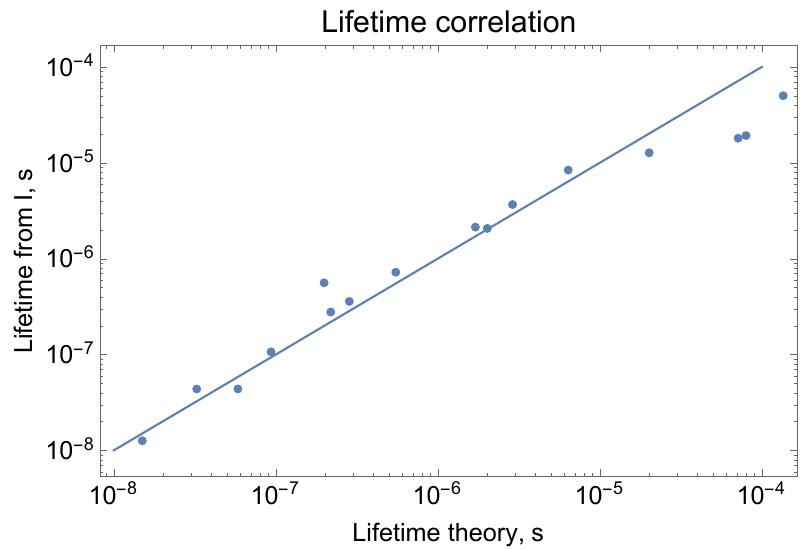
Figure 1. Comparison between theory and experiment for lifetimes of J = 2.5 odd states of Th II. Because of strong mixing of 20,120, 20,310, 20,686 cm − 1 states and 24,463 cm − 1 and 24,873 cm − 1 states, their average lifetimes were plotted with average energy used in the LTE equation. Lifetimes derived from experimental intensities “Lifetimes from I” (sum of intensities given by NIST for transitions from a specific level) were scaled with Boltzmann factor exp[-E/T] and multiplied by a coefficient for best match: T = 4000 cm − 1 and k =